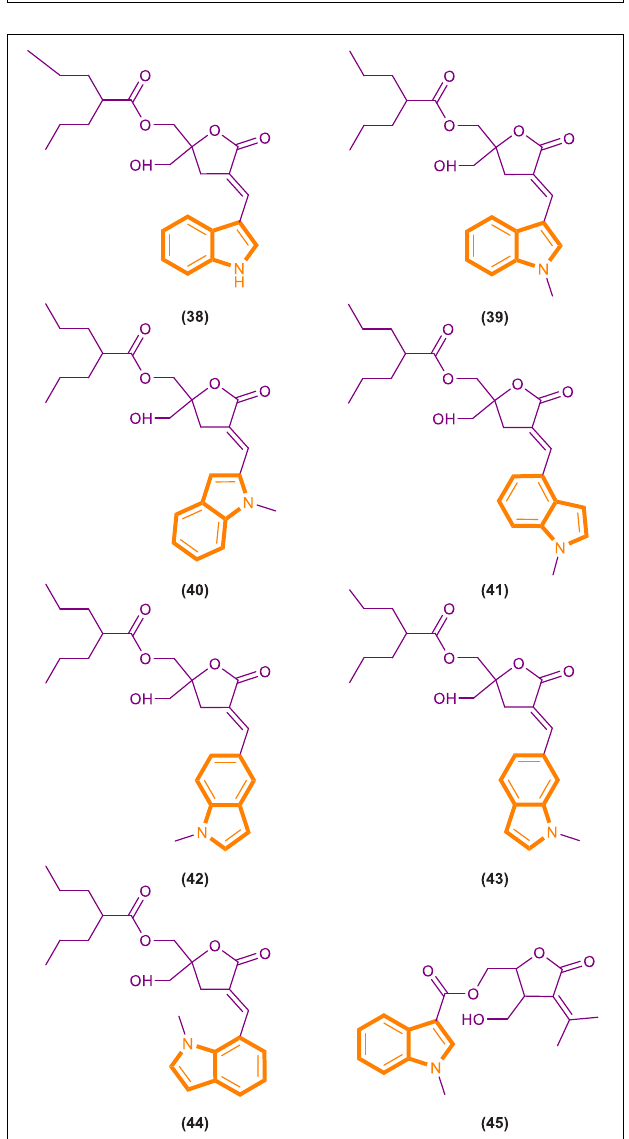
FIGURE 9 | DAG-indololactone analog (38–45). for PKC α , PKC ε , and RasGRP1 were determined in vitro by competition with bound (20-3H)phorbol 12,13-dibutyrate (PDBU) in the presence of 100 µ g/mL